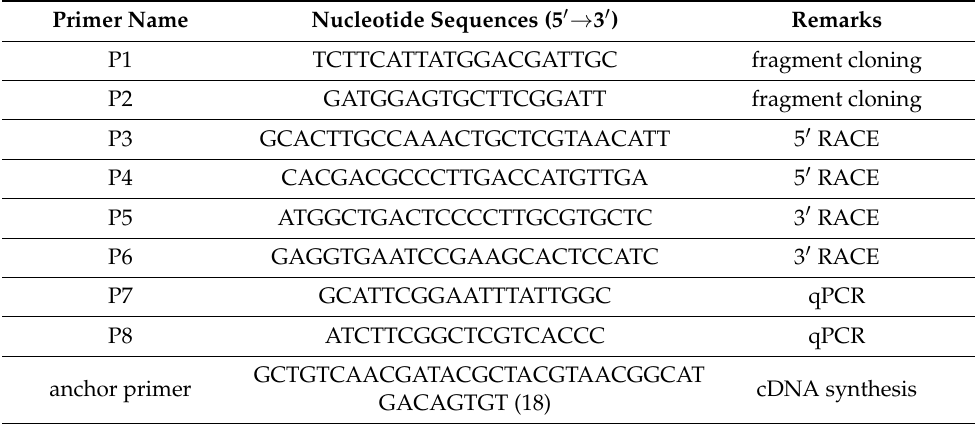
Table 1. List of primers in this